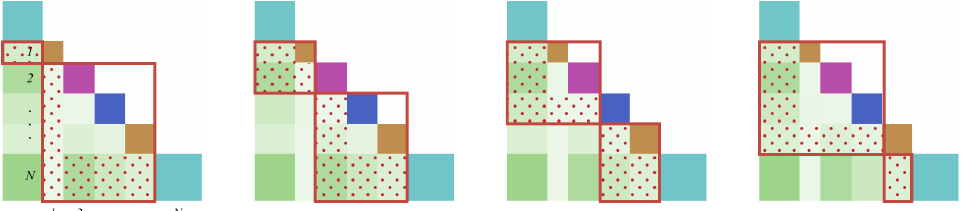
Figure 8. Examples of conceptual similarities used in the Line method. Each red square represents a topic segment. The light green squares with red dots inside the red squares indicate the conceptual similarities used in the Line